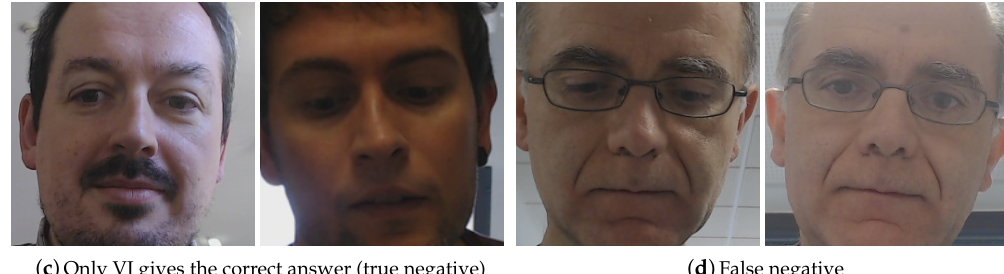
Figure 12. Examples of cases where at most one method gave the proper answer.